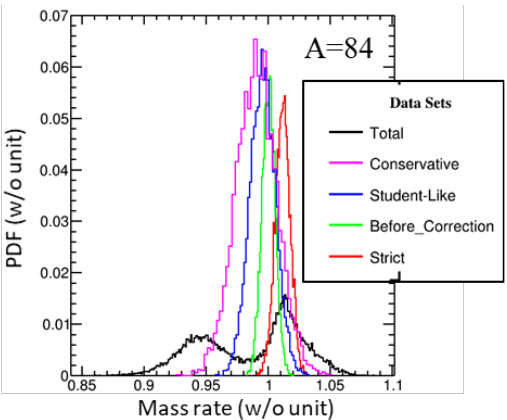
Fig. 17. PDF of evaluated mass rate before absolute normalization for a rejected